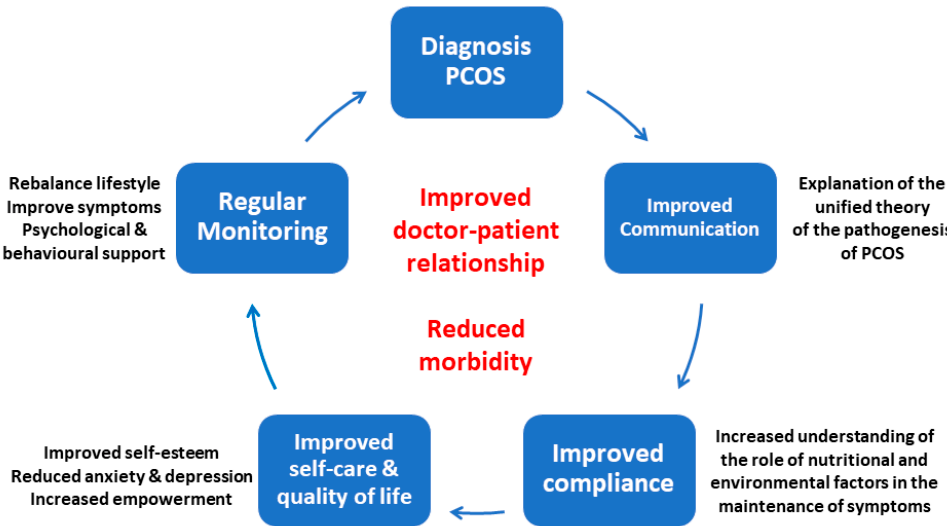
Figure 3. Impact of the unified theory on the management of polycystic ovary syndrome. Reprinted from Ref.